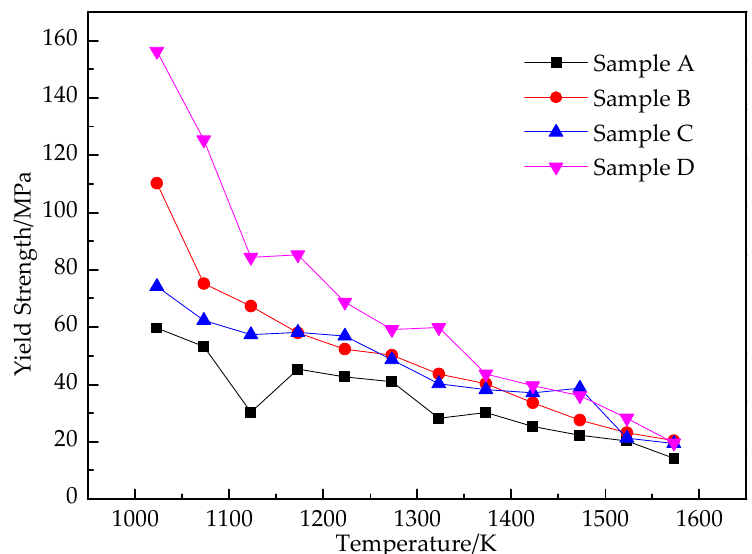
Figure 5. Relationship between yield strength and temperature of Q355GJ steel.